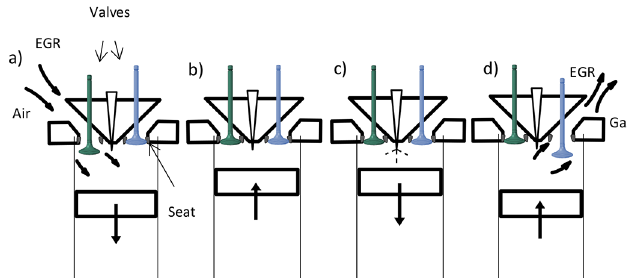
Fig. 2. 4-stroke diesel engine cycle highlighting the valve motion. a: inlet, b: compression, c: expansion-explosion, d: exhaust.